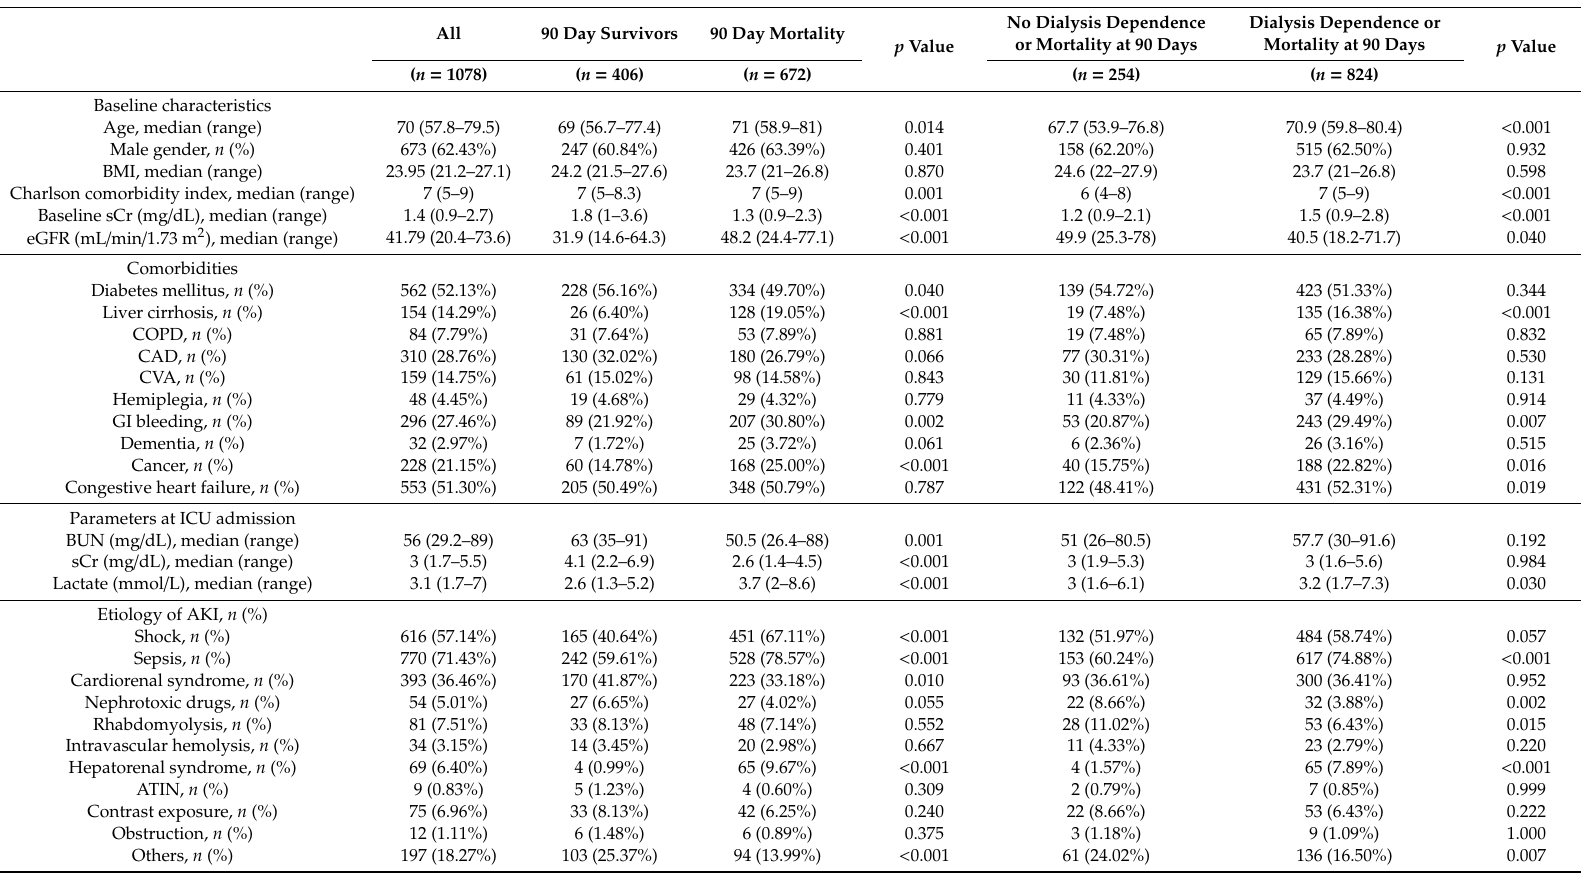
Table 2. Clinical characteristics of survivors and